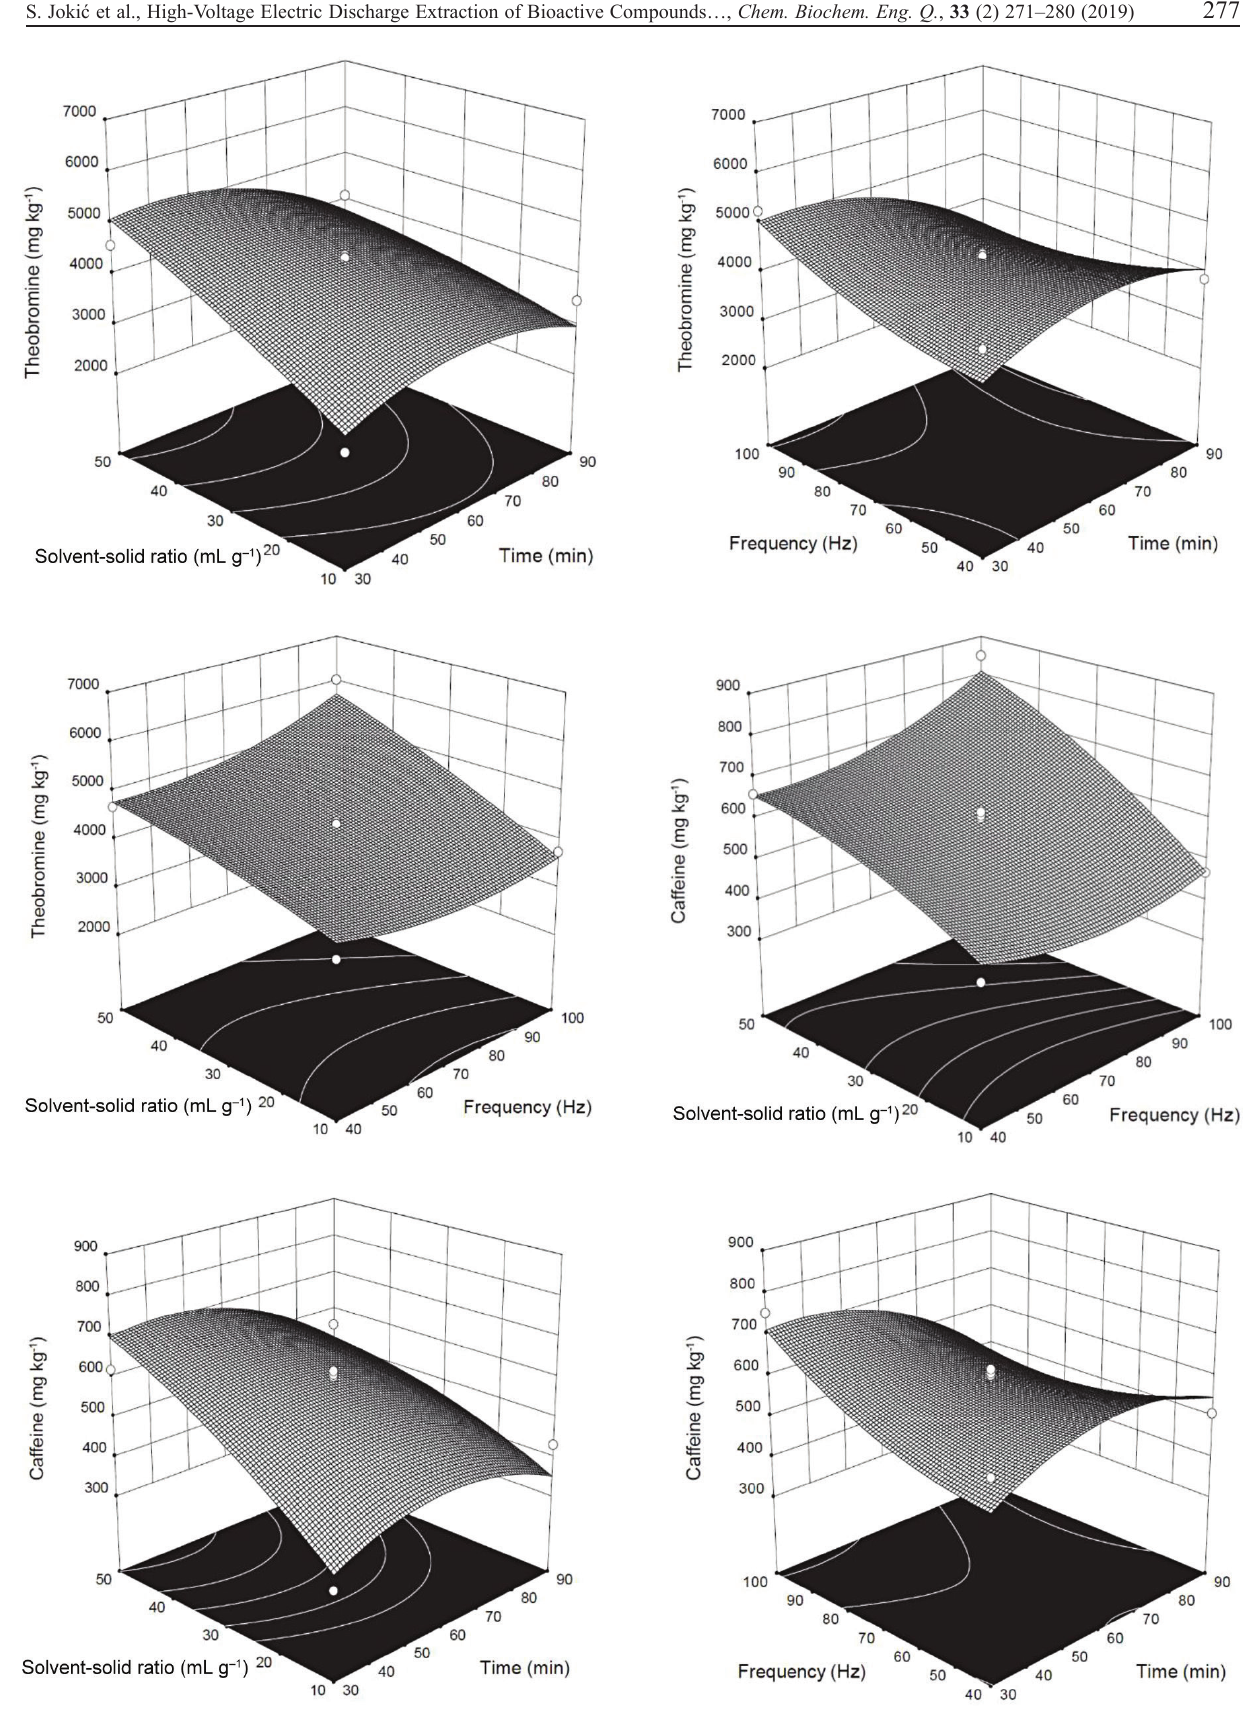
Fig. 1 – Response surface plots showing the effects of investigated variables on theobromine and caffeine content as a function of different process